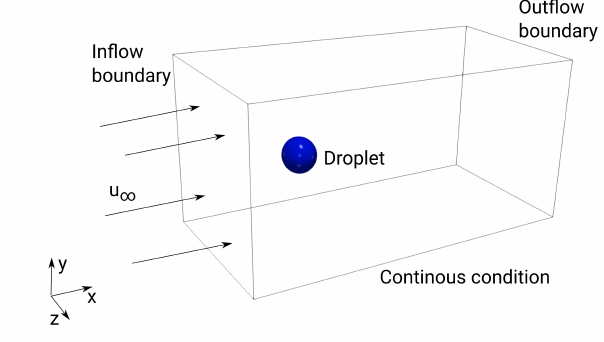
Figure 7. Computational domain (size: 10 D × 5 D × 5 D , grid resolution: 256 × 128 × 128) with boundary conditions for direct numerical simulations (DNSs) with